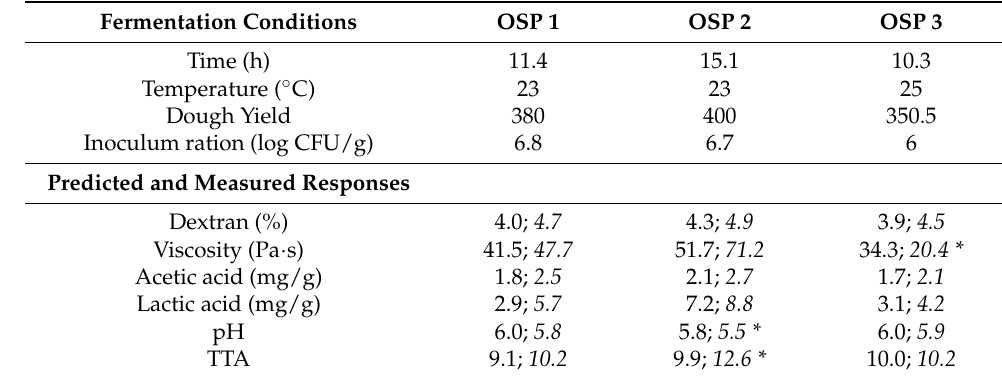
Table 4. Fermentation conditions of the optimal set points (OSP) for maximized dextran and mini- mized acidity and their predicted and measured responses ( in italics